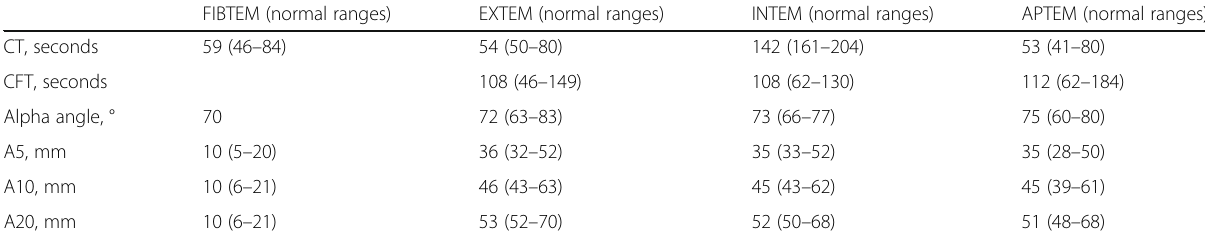
Table 2 ROTEM results before cesarean delivery FIBTEM (normal ranges) EXTEM (normal ranges) INTEM (normal